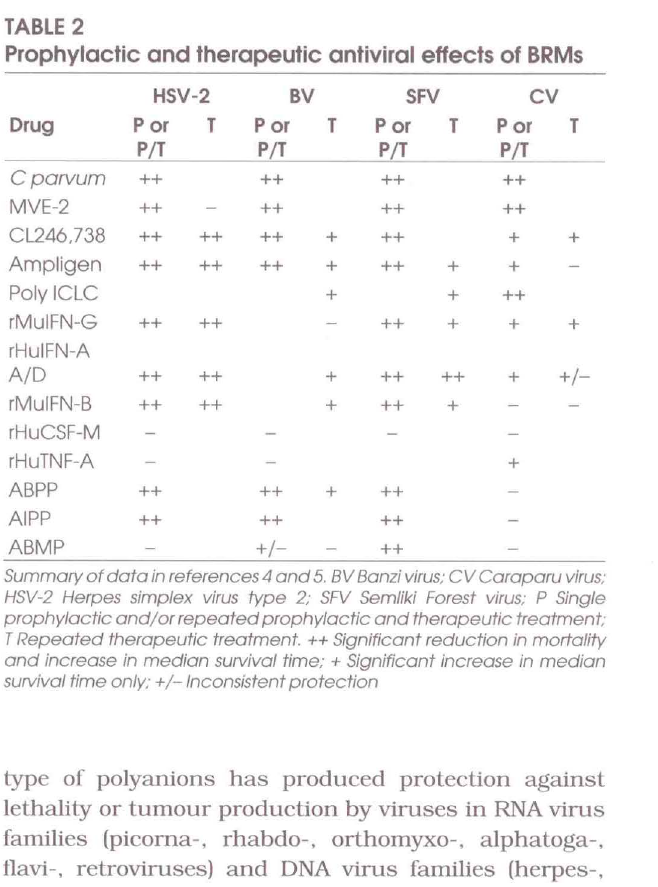
Prophylactic and therapeutic antiviral effects of BRMs Pleotropic immunomodulatory effects of regimens of